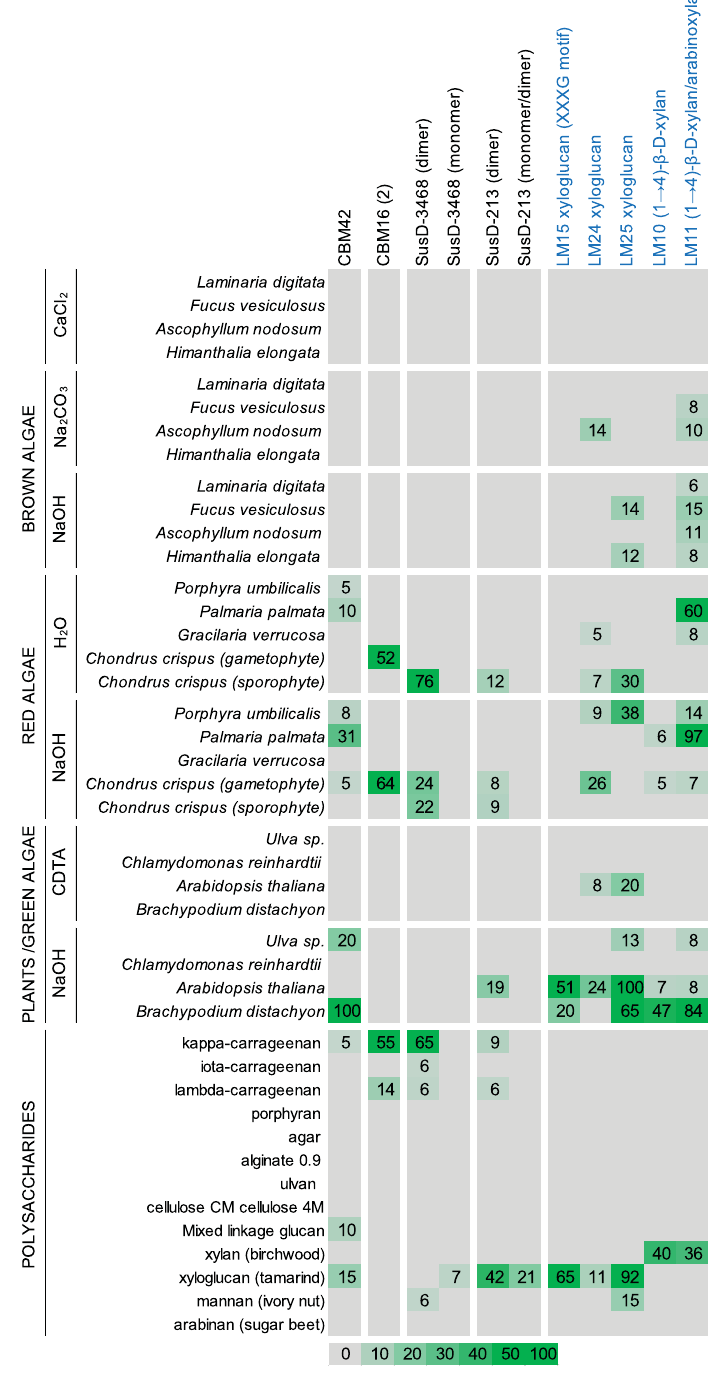
Figure 4. Evaluation of the recognition abilities of the purified probes by standard CoMPP analysis. CoMPP binding profiles of purified CBM and SusD-like proteins towards a range of cell wall extracts and commercial polysaccharides. Monoclonal antibodies (LM10, LM11, LM15, LM24, LM25) that bind the indicated plant polysaccharides were used as binding controls. Results are means of three individual experimental replicates. The colour scale in relation to absorbance values is shown. The highest mean signal value in the entire data set was set to 100 and all other signals adjusted accordingly. Values < 5 were considered as background and